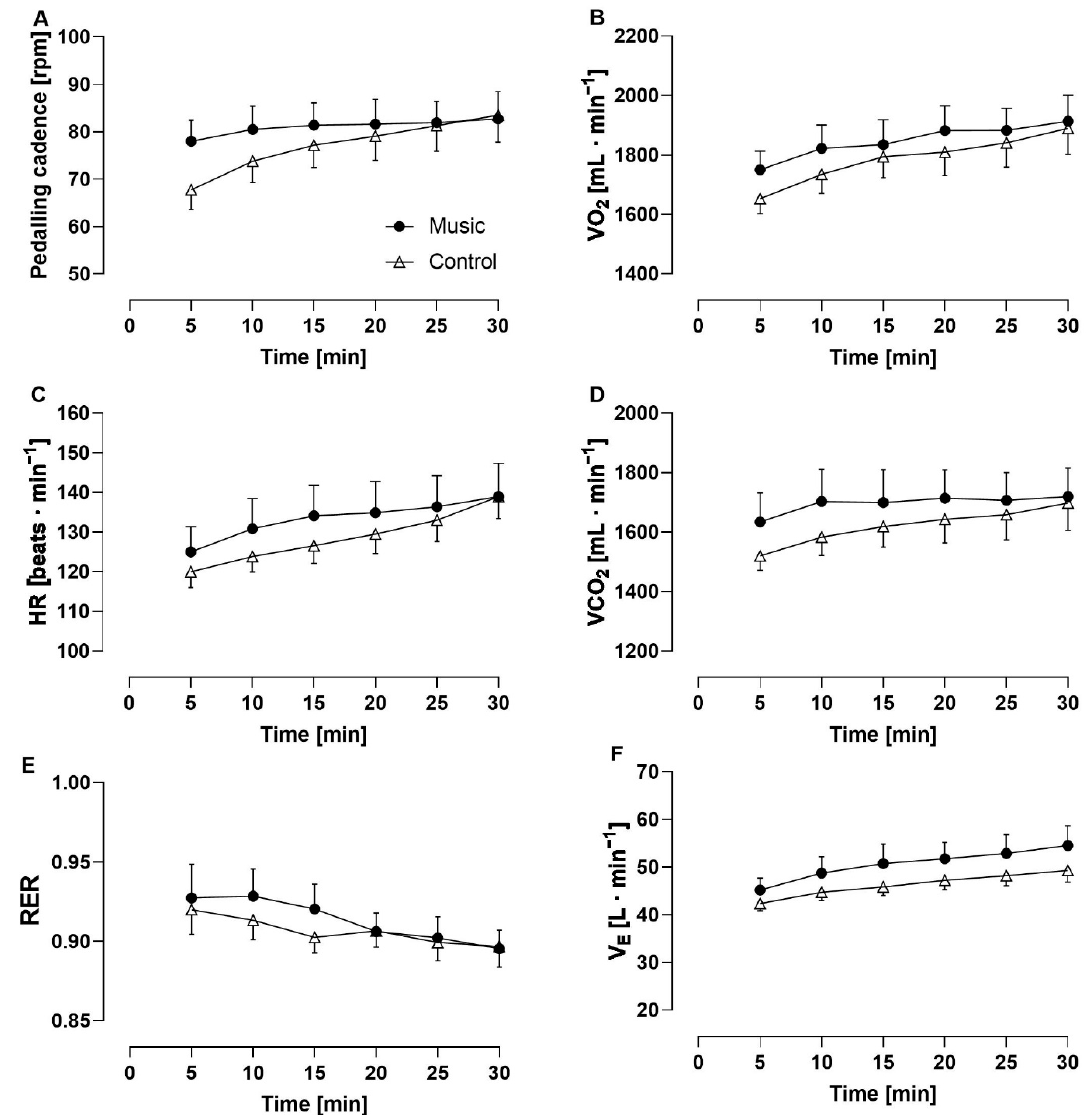
Figure 7. Time course of pedaling cadence ( A ), oxygen uptake ( B ), heart rate ( C ), carbon dioxide output ( D ), respiratory exchange ratio (RER) ( E ), and minute ventilation ( F ) for the music condition (filled circles) and the control condition (open triangles).